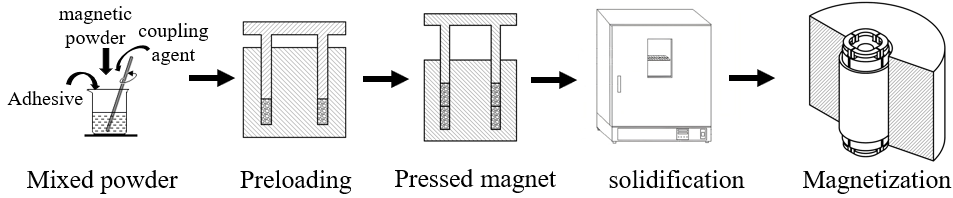
Figure 1. Bonded magnet process route.